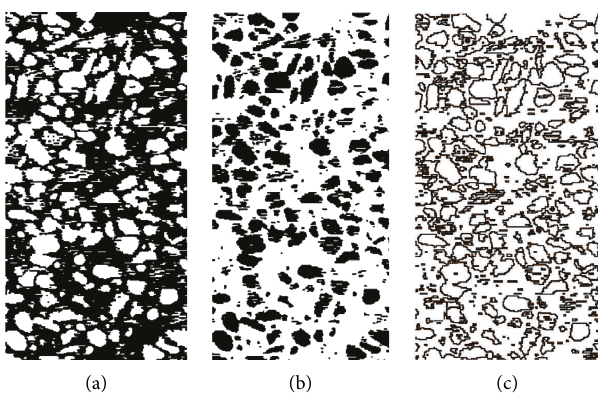
Figure 10: Profile of every material in the CT section after reconstruction. (a) Mortar. (b) Aggregate. (c) Interface.